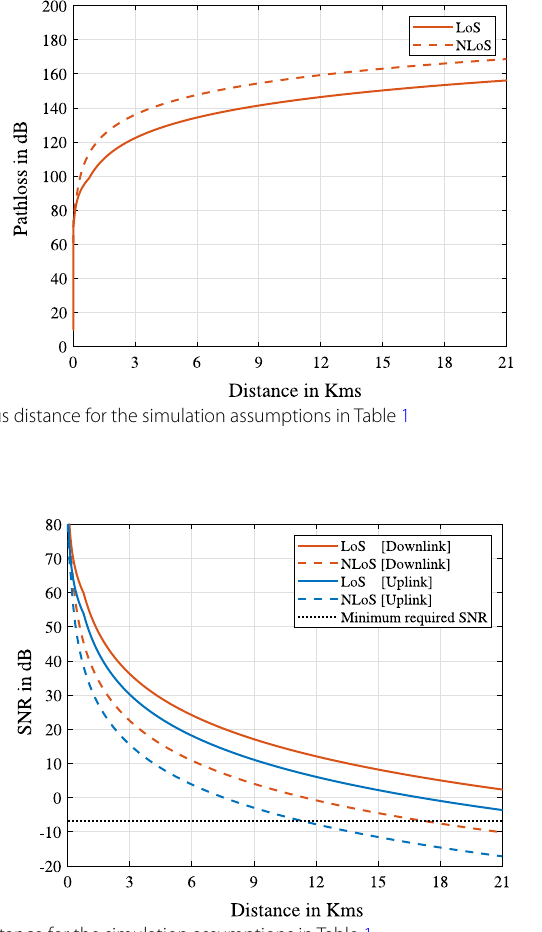
Fig. 3 SNR versus distance for the simulation assumptions in Table